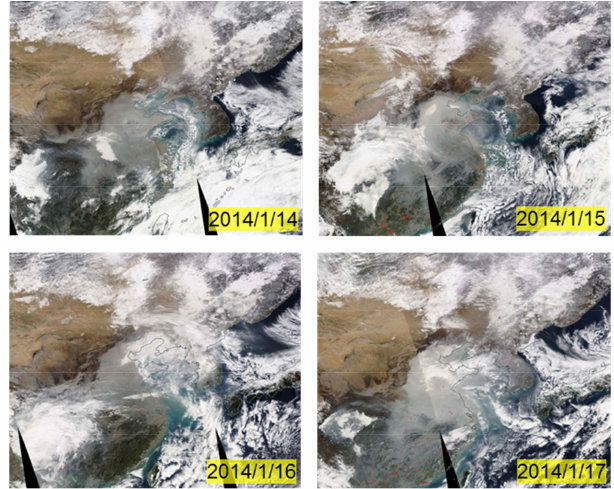
Figure 6. MODIS RGB images over east Asia during 14–17 Jan- uary